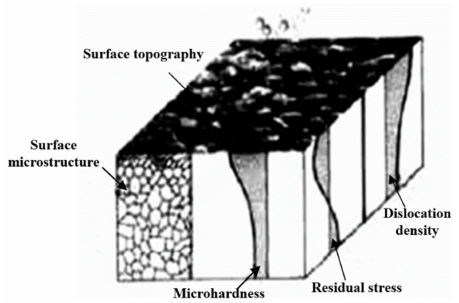
Figure 3. Surface integrity and their corresponding distribution after shot peening